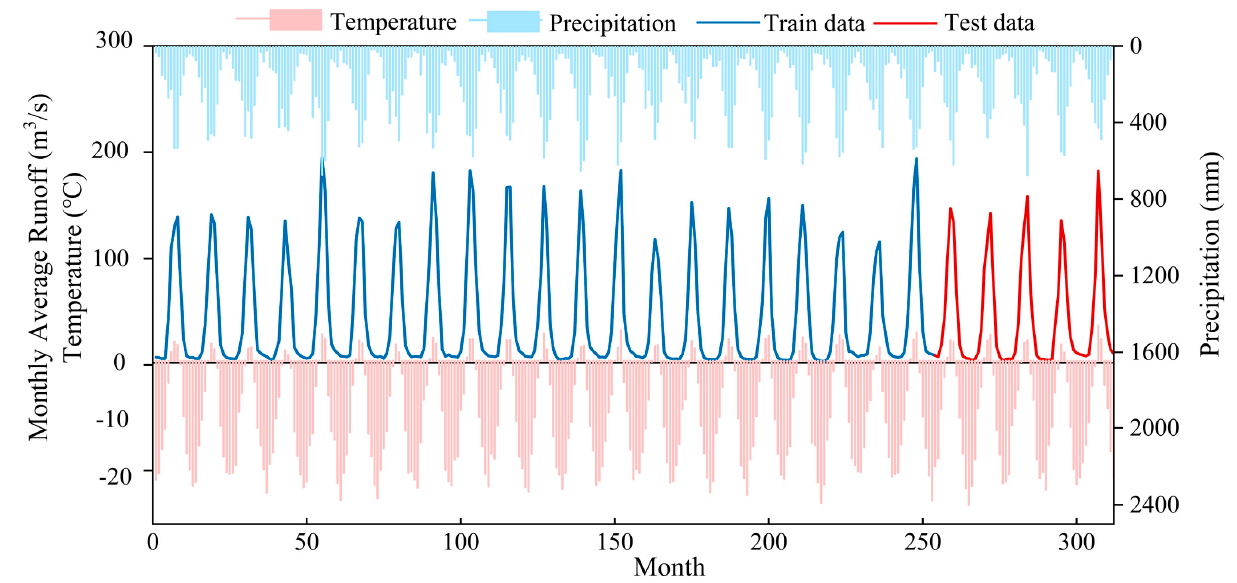
Figure 4. Average monthly runoff, air temperature, and precipitation at Pochengzi hydrological station from 1990–2015.